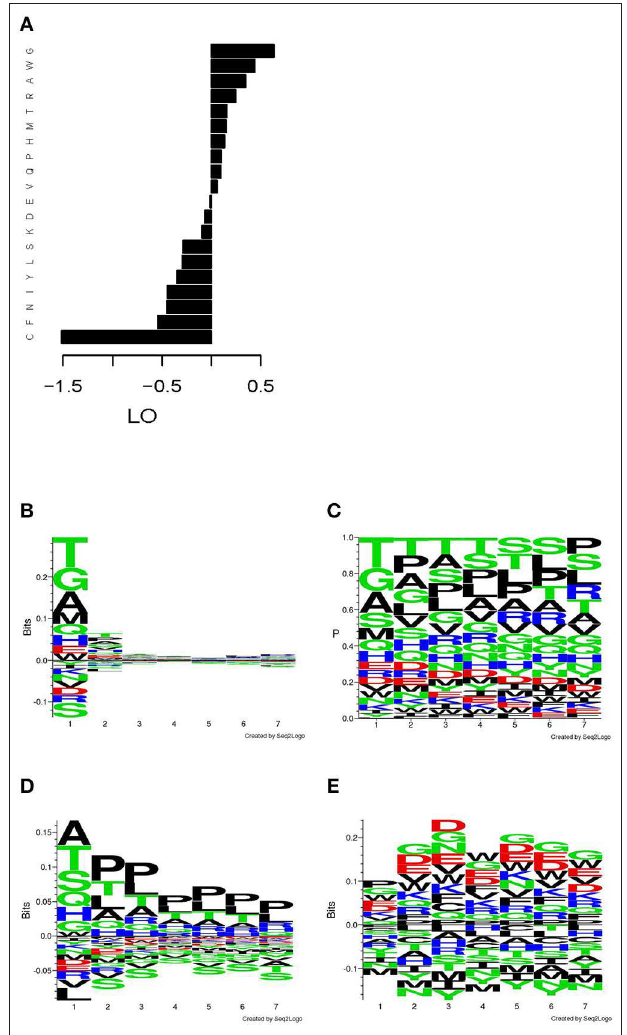
FIGURE 2 | Distribution of the amino acid residues in the mimotope library. (A) Log odds (LO) relative to background frequencies. (B) Sequence logo of the LO by position relative to the overall background frequencies. (C) Sequence logo of the frequencies by position. (D) Sequence logo of the LO by position in an amplified Ph.D.-7 phage library without ligand selection relative to the overall background frequencies (based on W. L. Matochko, R. Derda. “Error analysis of deep sequencing of phage libraries: peptides censored in sequencing”. Comput Math Methods Med , 2013, 491612. 2013., http://www. chem.ualberta.ca/~derda/parasitepaper/rawfiles/PhD7-GAC-30FuR.txt). (E) Sequence logo of the LO by position relative to the frequencies by position